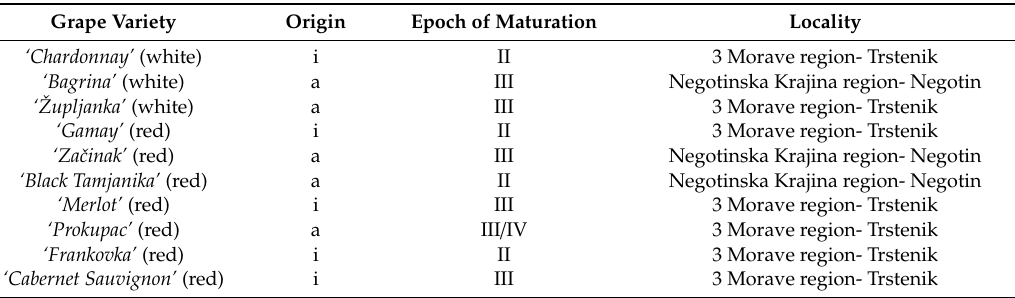
Table 1. Characteristics of grape